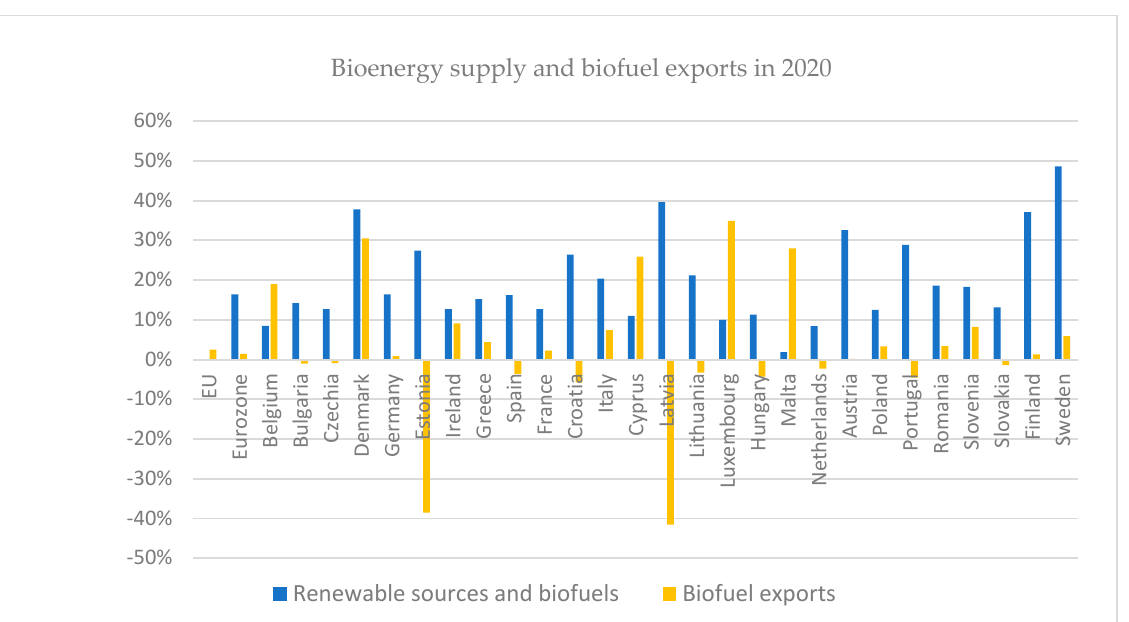
Figure 3. The supply of bioenergy and the export of biofuels in the EU member-states. Source: Authors’ original compilation based on the Eurostat data [88,89].